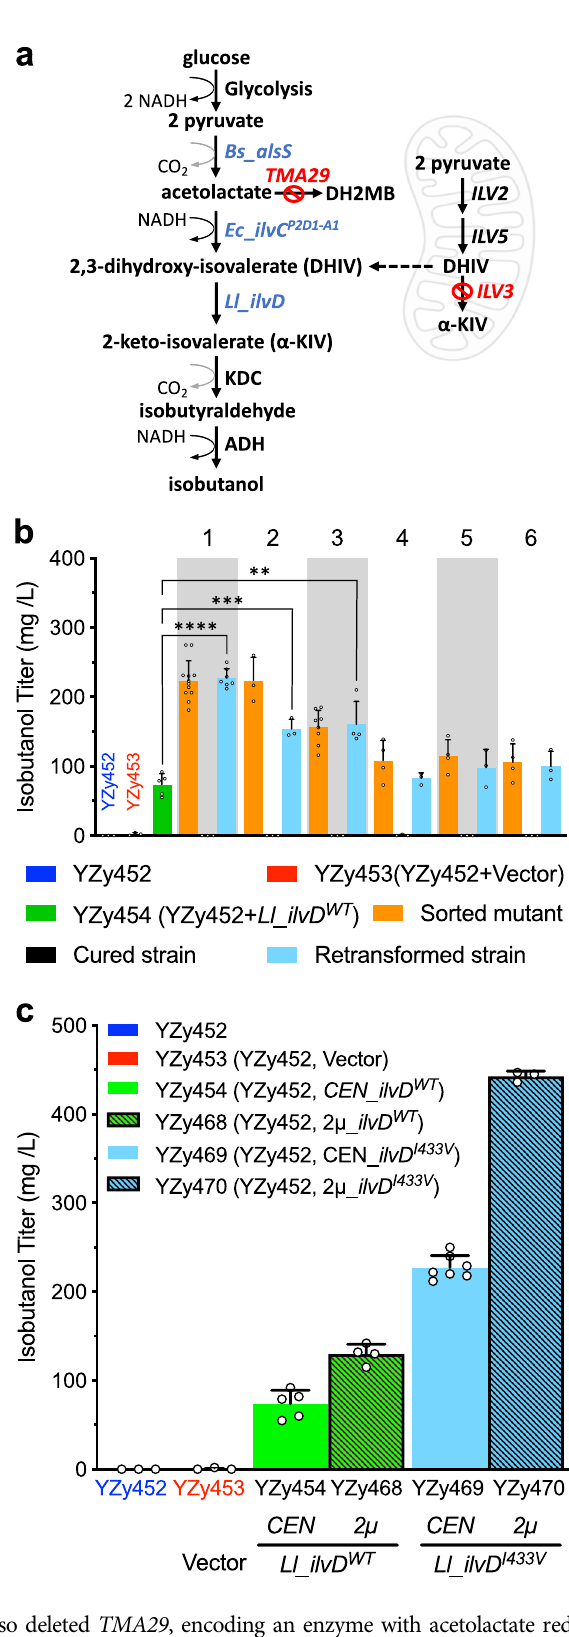
(Supplementary Tables 1, 2), and sorted for transformants with the highest fl uorescence intensity. After three rounds of FACS, 20 randomly picked colonies produce an average of 296 ± 19 mg/L isobutanol from 15% galactose, with the highest producing strain